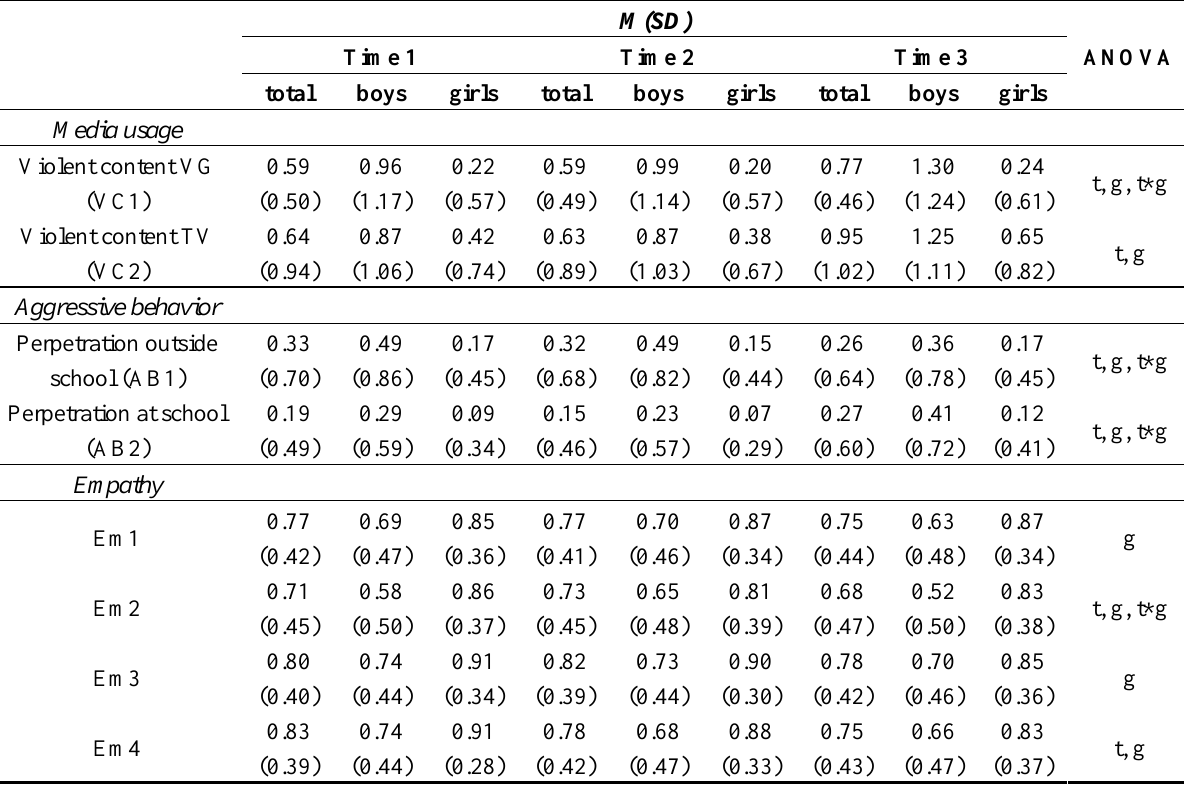
Table 1. Descriptive